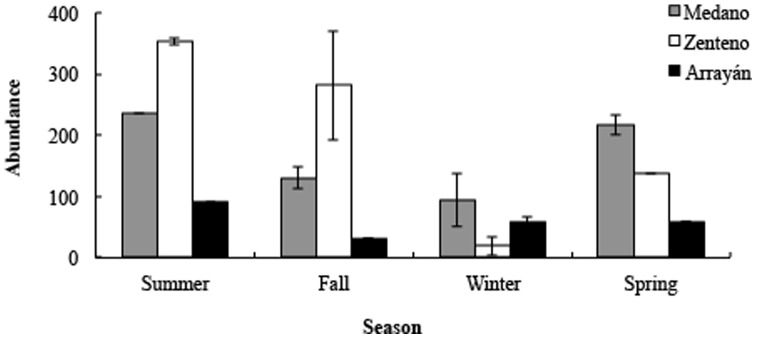
Seasonal and geographical comparisons of mean lizard abundance.Vertical lines represent standard errors.